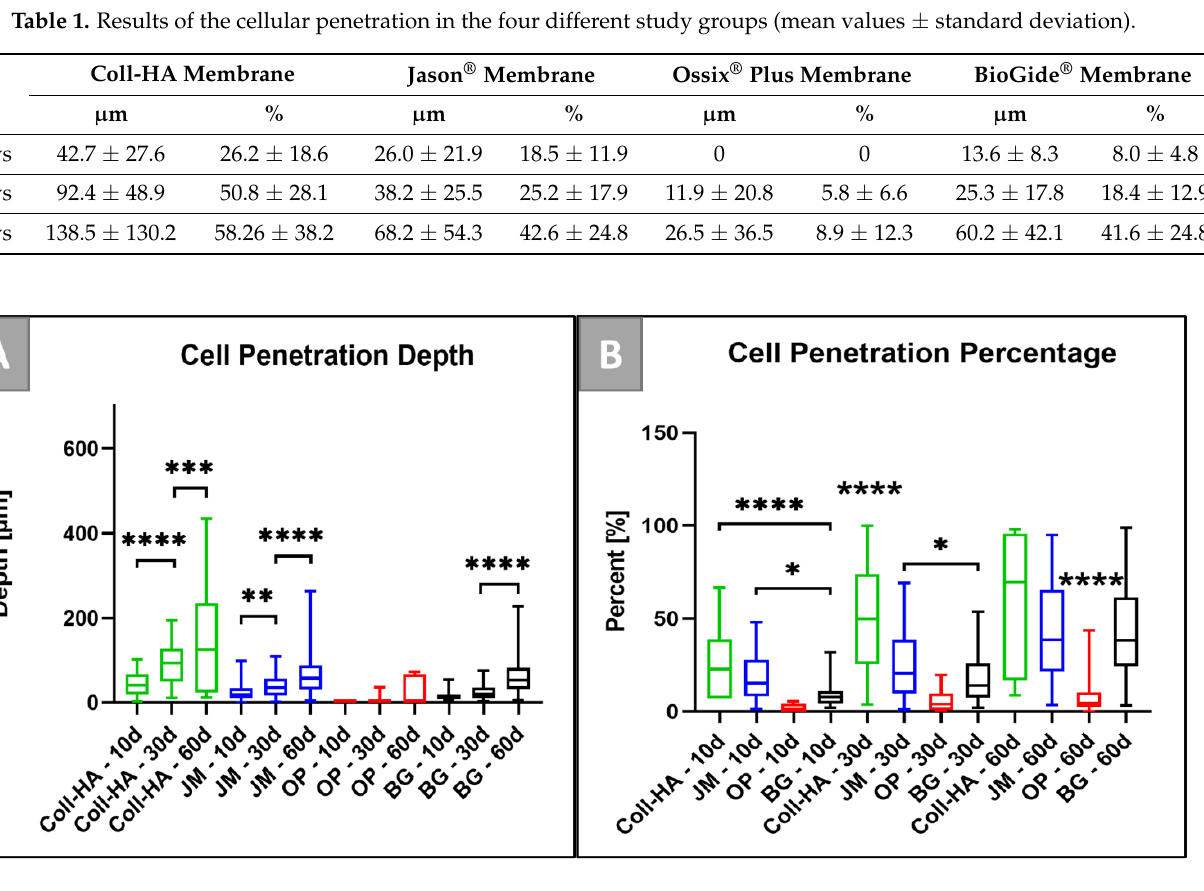
Figure 5. Histomorphometrical results of ( A ) the cellular penetration depth (in μ m) and ( B ) the cellular penetration (in %) (* p < 0.05, ** p < 0.01, *** p < 0.001, and **** p < 0.0001).